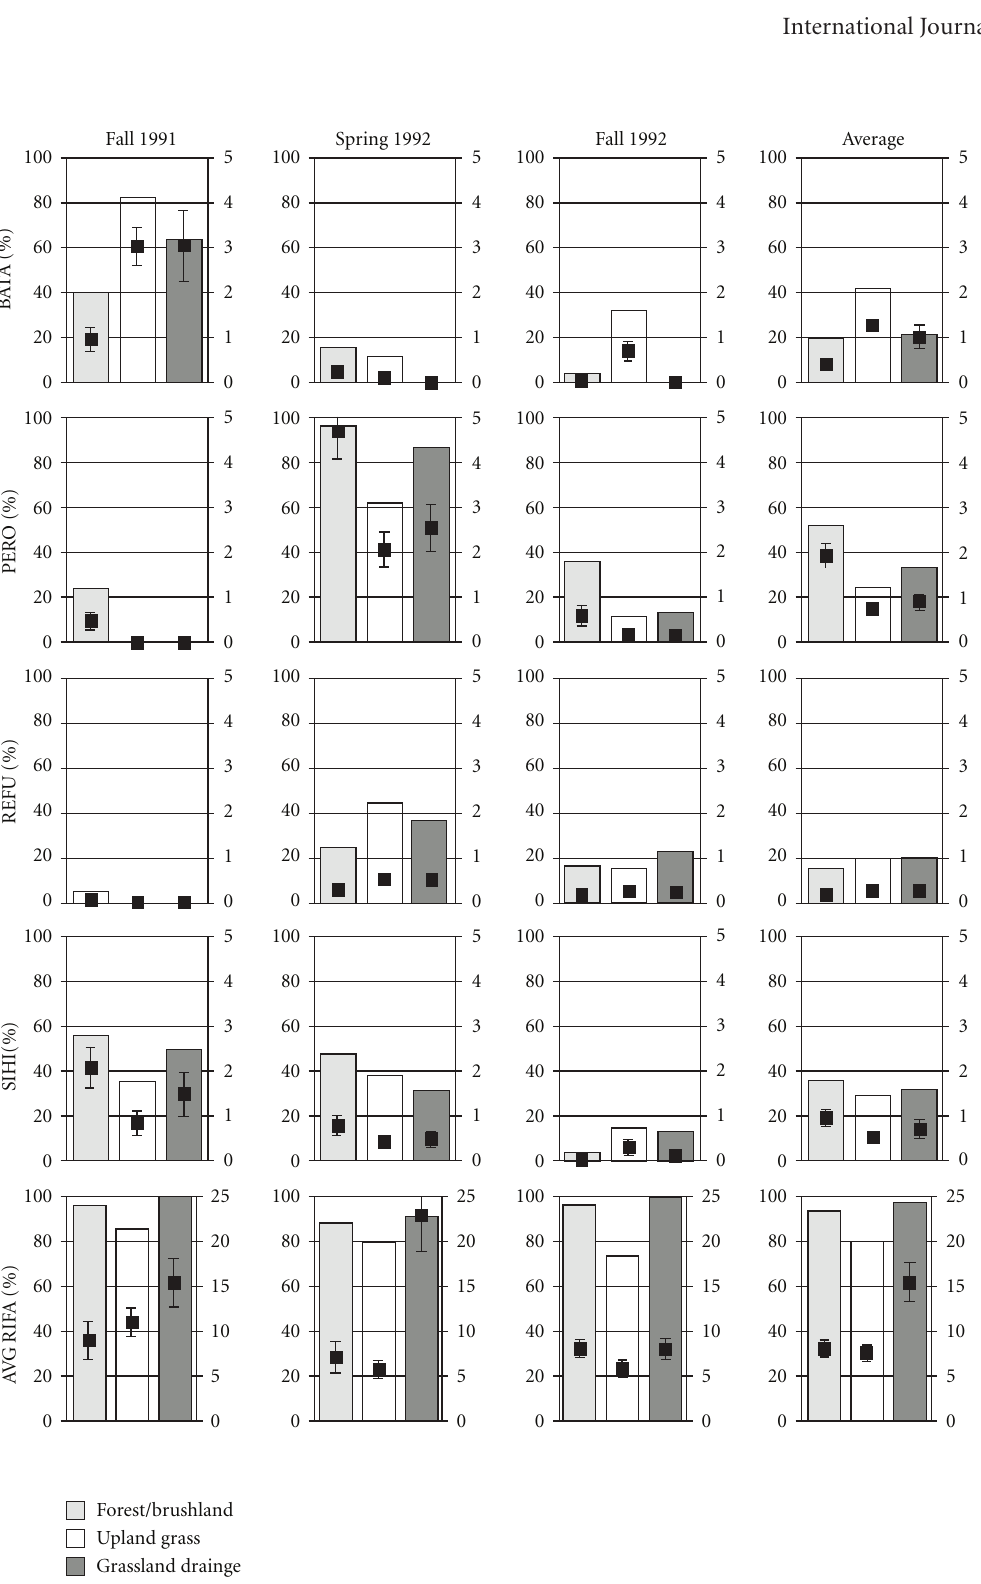
Figure 2: Columns indicate the mean proportion of each of the three habitat types (forest/brushland, upland grassland, and grassland drainage) occupied by pigmy mice (BATA), white-footed mice (PERO), fulvous harvest mice (REFU), hispid cotton rats (SIHI), and red imported fire ants (RIFA), Texas A&M University Range Area, fall 1991, spring 1992, and fall 1992. Points indicate mean abundance ( ± SE) per trapping point (100m 2 area) in each of the three habitat